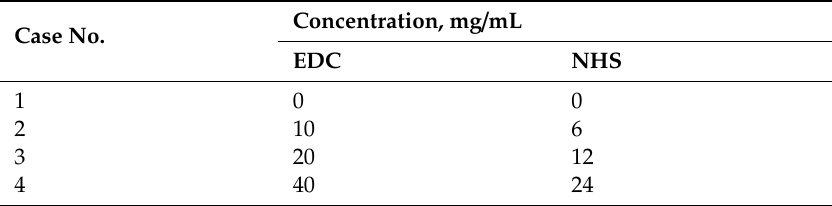
Table 2. The molar ratio of the crosslinking couple.